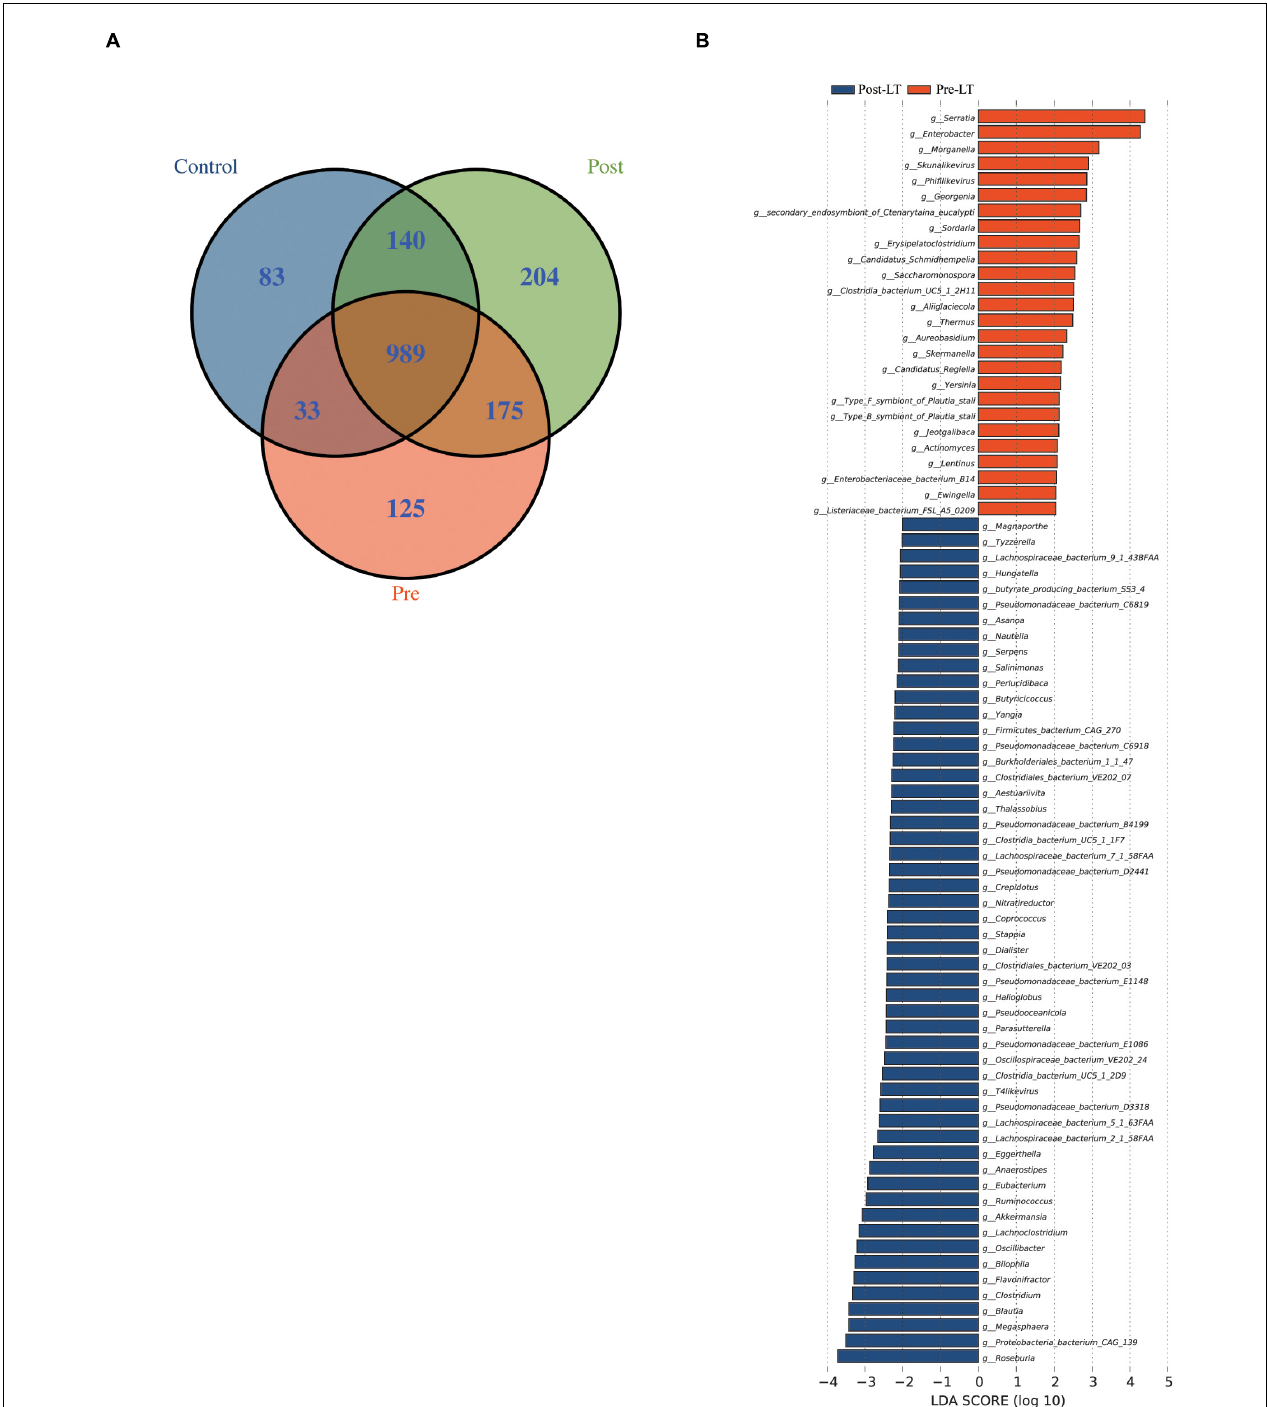
FIGURE 2 | (A) Venn diagram of the pre-LT, post-LT, and control groups. (B) LEfSe analysis of the gut microbiota composition between the pre-LT and post-LT groups. Histogram of the LDA scores calculated for the differential abundance of genera in the two groups. Different colors represent different groups.